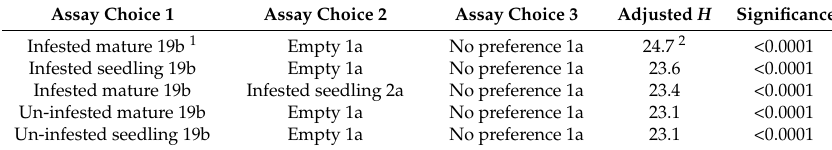
Table 1. Rhyzobius lophanthae adult search responses to Y-tube olfactometer volatiles in charcoal-filtered air. Cumulative responses of 20 adults that made decisions in air that was charcoal-filtered. N = 10 trials, 200 adults